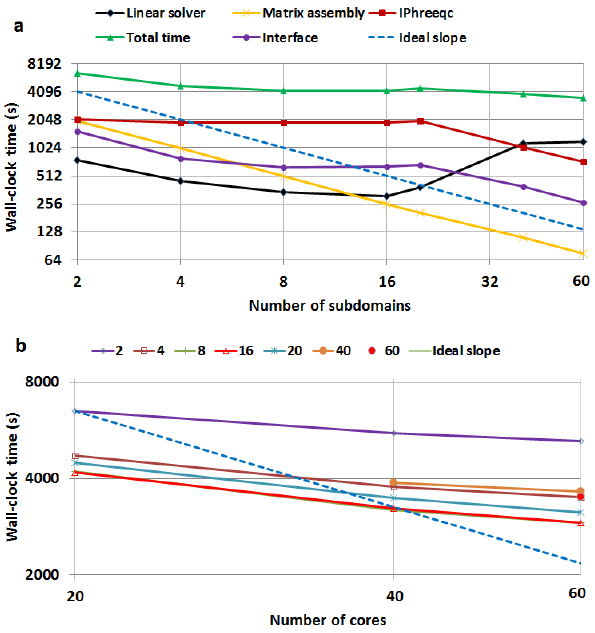
Figure 13. Analysis of the simulation time as functions of subdo- mains and compute cores. (a) Breakdown of the total time corre- sponding to speedup curve AB in Fig. 13. Twenty cores are em- ployed for DDCs from 2 to 20; for more DDCs, the same number of cores and DDCs are applied. (b) Total simulation time as a func- tion of compute cores for different DDCs varying from 2 to